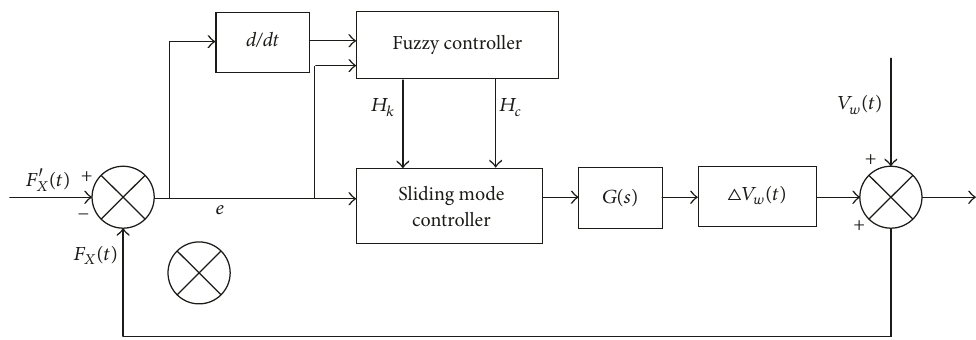
Figure 4: Fuzzy-sliding mode control scheme.